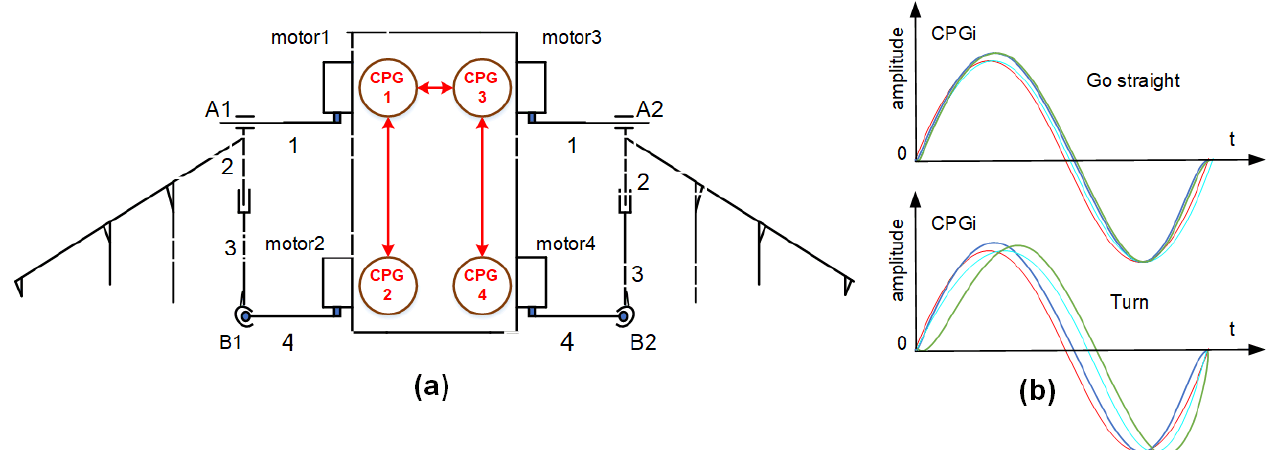
Figure 5. Analysis of the flapping propulsion method. The motors 1, 2, 3, and 4 are controlled by CPG 1, 2, 3, and 4, respectively. ( a ) Schematic diagram of the pectoral fins and CPG network topology; ( b ) the four CPG outputs when the robot goes straight and turns. When the robot goes straight, the CPG 1 and CPG 3 output the same signals, and the CPG 2 and the CPG 4 output the same lines. When the robot turns, the CPGs will output different drive signals. The red, bule, green, and brown lines denote the CPG1, CPG2, CPG3, and CPG4, respectively.